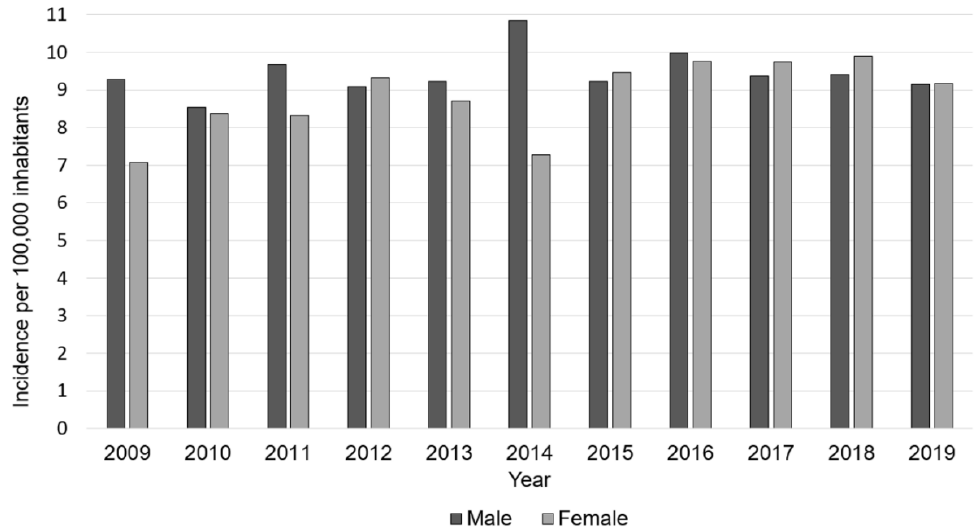
Figure 1. Development of osteomyelitis incidence from 2009 to 2019, divided by gender. The light grey bars present the incidence of male cases, and the dark grey bars present the incidence of female cases.